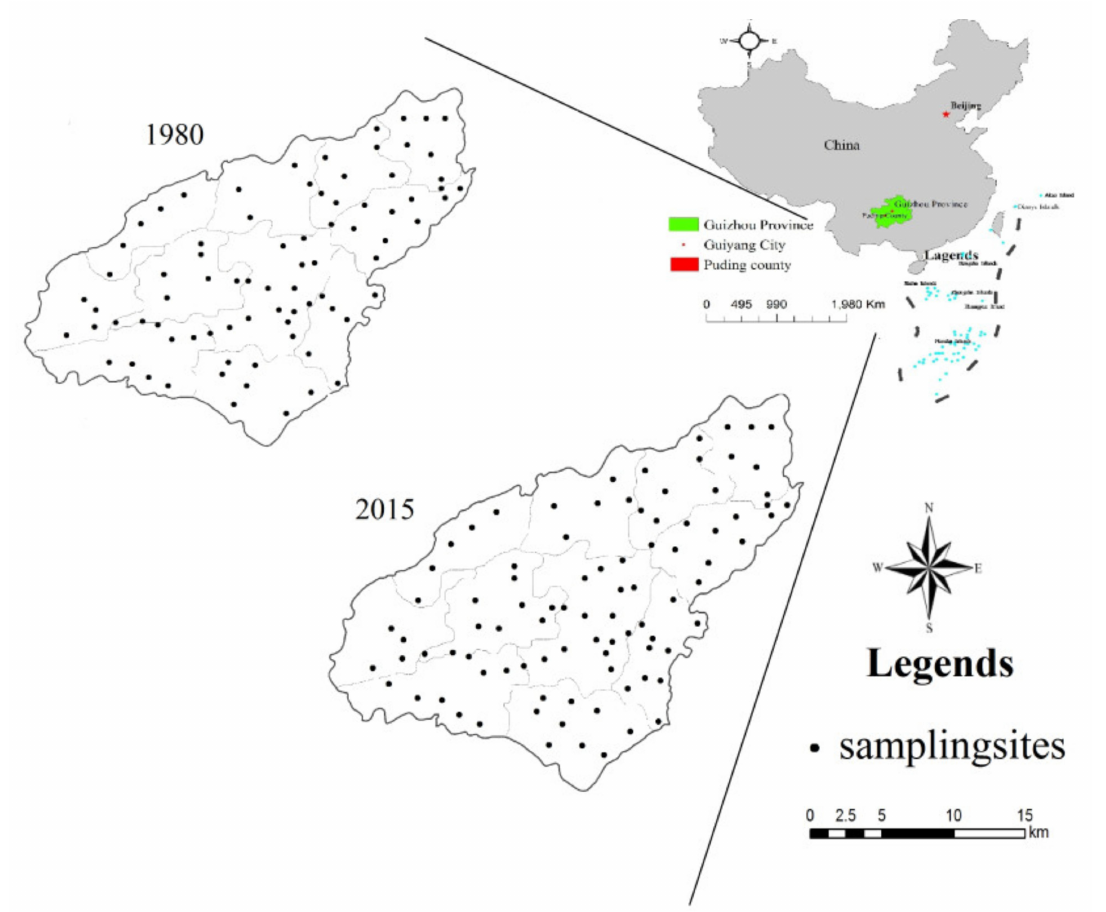
Figure 2. Study area location and soil sampling map of study